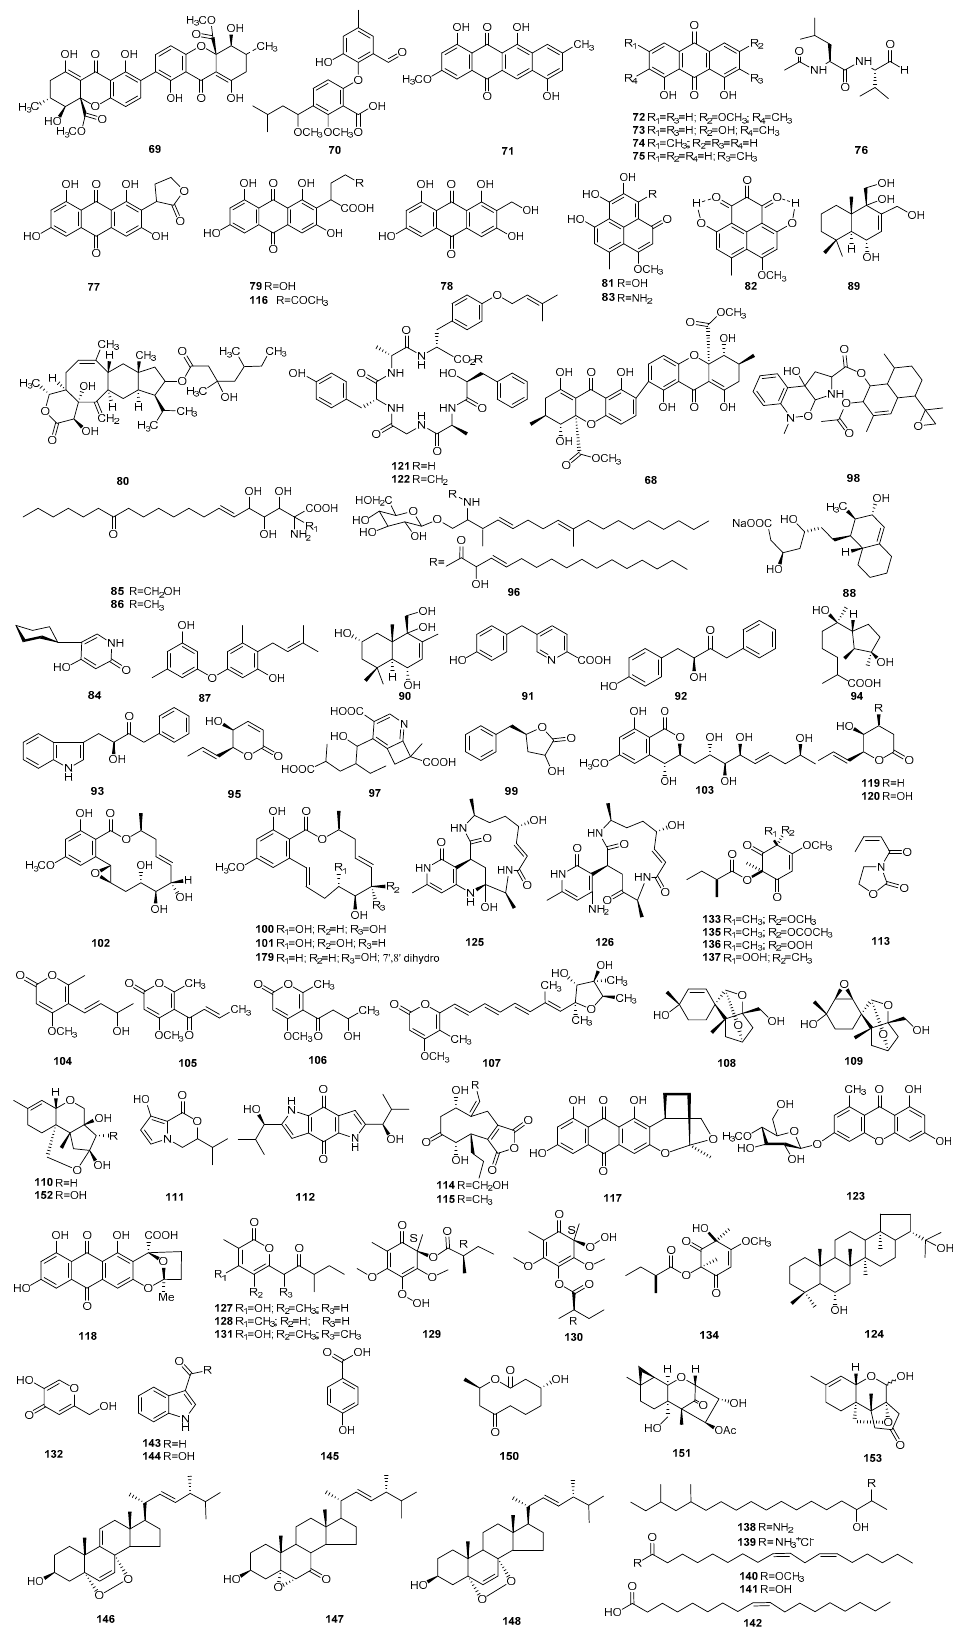
Figure 2. The structures of metabolites produced by Paecilomyces ( 2 ).